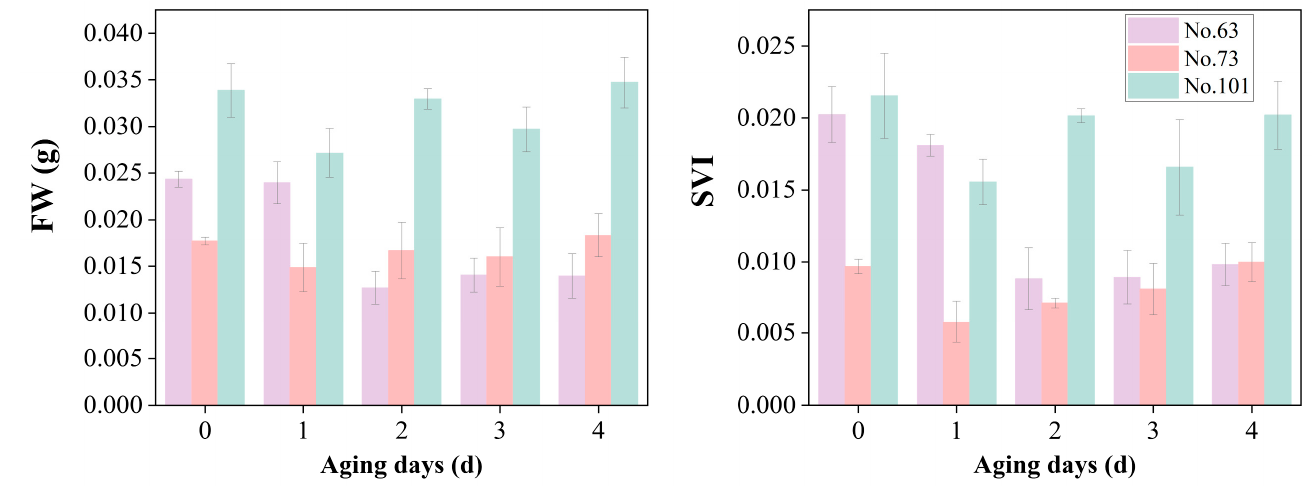
Figure 8. Effect of aging days on average fresh weight (FW) and simple vigor index (SVI) of three varieties of pepper seedlings.